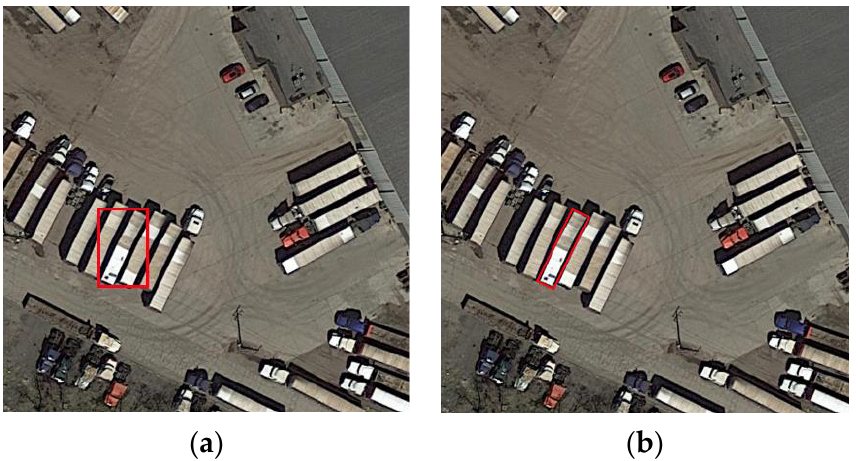
Figure 1. ( a ) Oriented objects with horizontal bounding boxes. ( b ) Oriented objects with oriented bounding boxes.